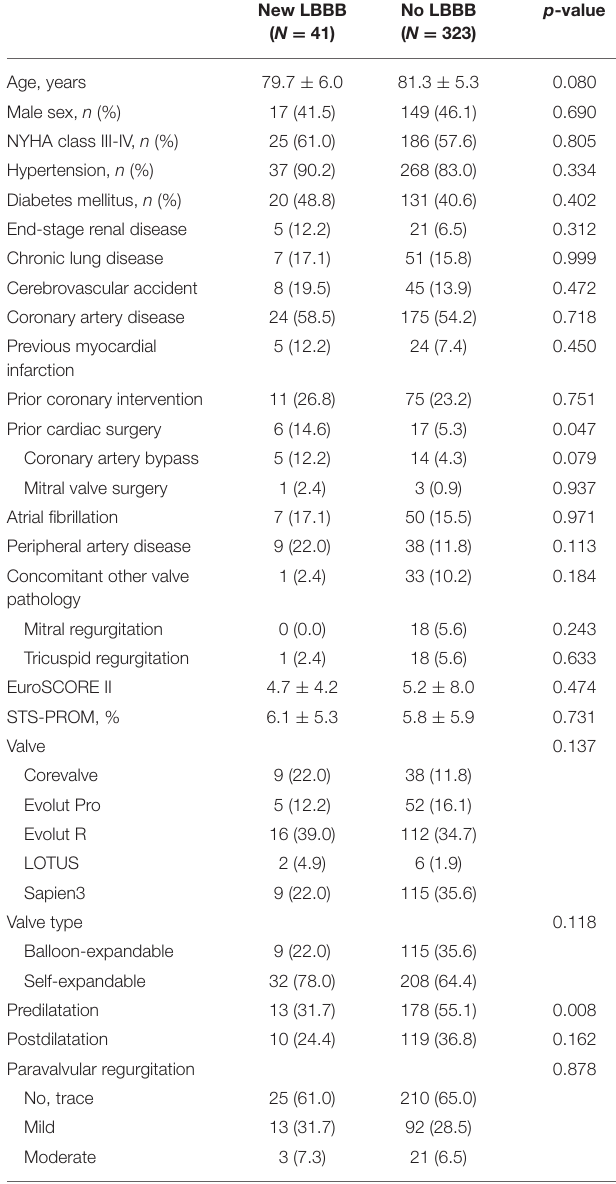
TABLE 1 | Baseline